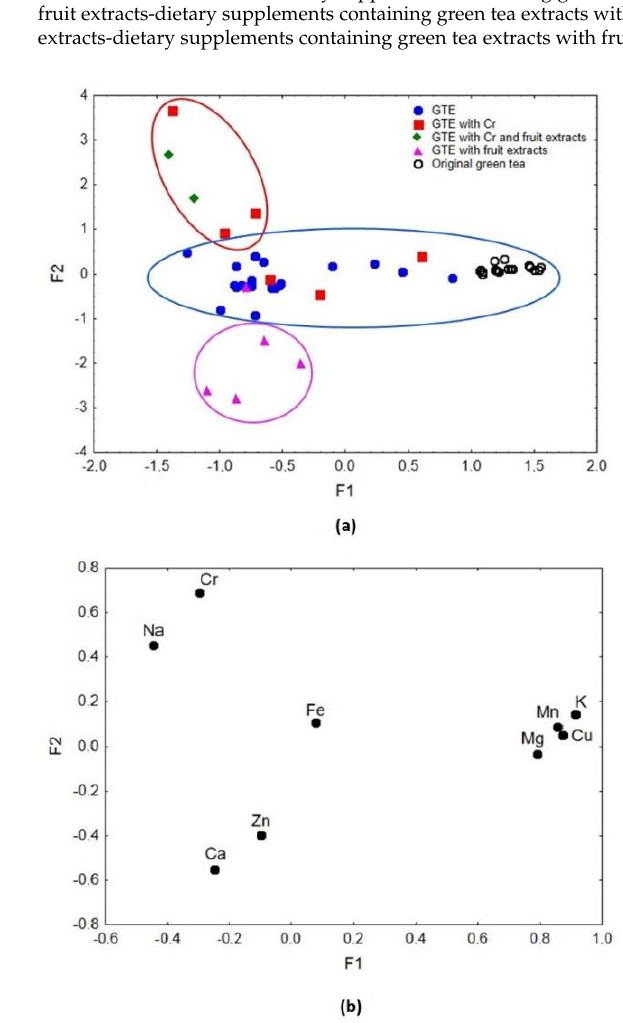
Figure 2. ( a ) Scatterplot of object samples for two factors of the analysed dietary supplements (GTE — dietary supplements containing green tea extracts. GTE with Cr — dietary supplements containing green tea extracts with chromium; GTE with Cr and fruit extracts — dietary supplements containing green tea extracts with chromium and fruit extracts; GTE with fruit extracts — dietary supplements containing green tea extracts with fruit extracts) and green tea samples. ( b ) Scatterplot of objects samples of two factors of the analysed dietary supplements and green tea samples. The data concerning green tea are based on Brzezicha-Cirocka et al. [39].